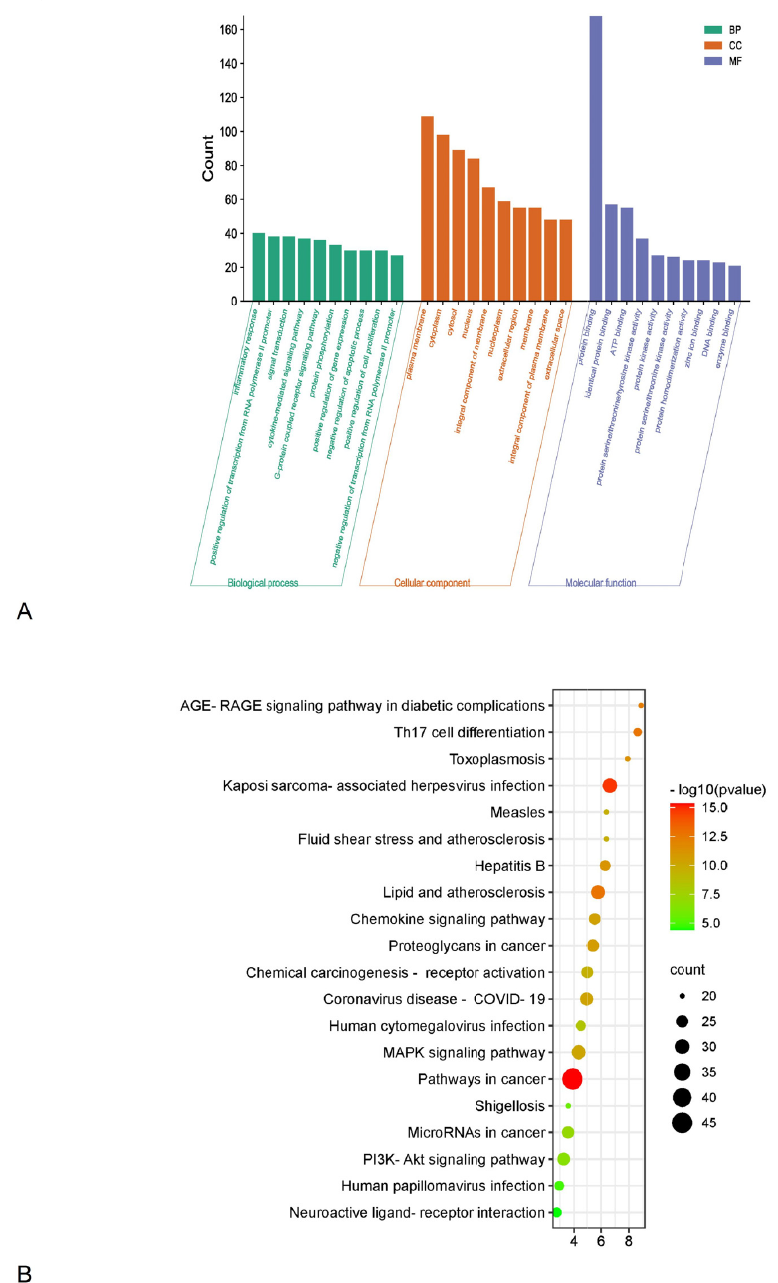
Figure 5. GO function and KEGG pathways analysis enrichment. ( A ) GO function (BP: biological process; CC: cellular component; MF: molecular function); ( B ) KEGG pathways enrichment bubble